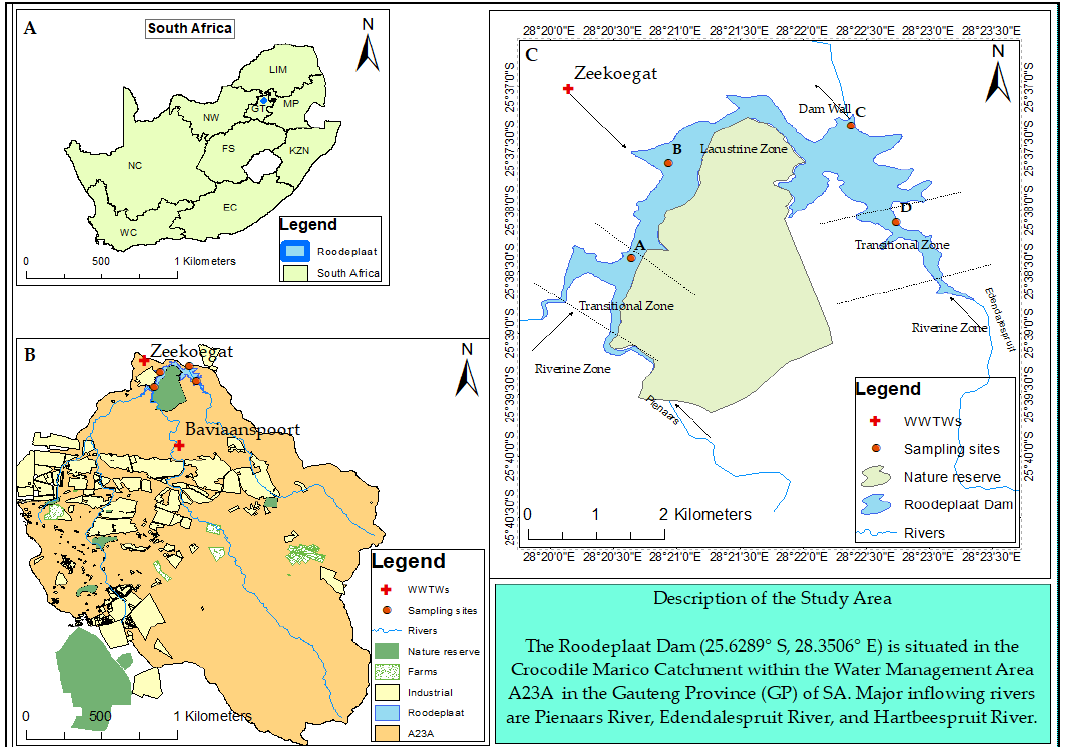
Figure 1. The map of the study area, indicating ( A ) the location of the Roodeplaat Dam in South Africa; ( B ) dominant land uses in Water Management Area A23A; and ( C ) the sampling sites, the flow direction, and the different zones of the dam.